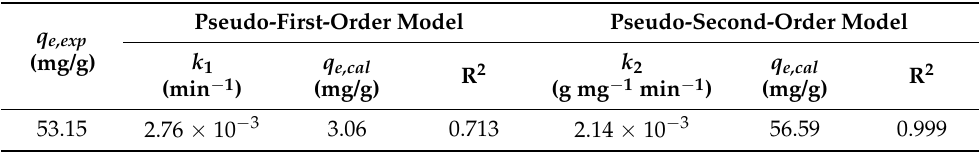
Figure 10. ( a ) Effect of contact time and ( b ) effect of adsorbent dosage on percentage of iodine adsorption by Li-Al-DBS sample; ( c ) adsorption isotherm study; ( d ) plot of adsorption isotherm data fitted using Langmuir isotherm model; ( e ) pseudo-first-order kinetics and ( f ) pseudo-second-order kinetics for iodine adsorption on Li-Al-DBS sample. The dotted line in ( a ) represents the equilibrium iodine adsorption. Table 5. The correlated parameters of pseudo-first-order and pseudo-second-order kinetic models for Table 4. Characteristic parameters obtained by the Langmuir and Freundlich isotherm models. iodine adsorption on Li-Al-DBS